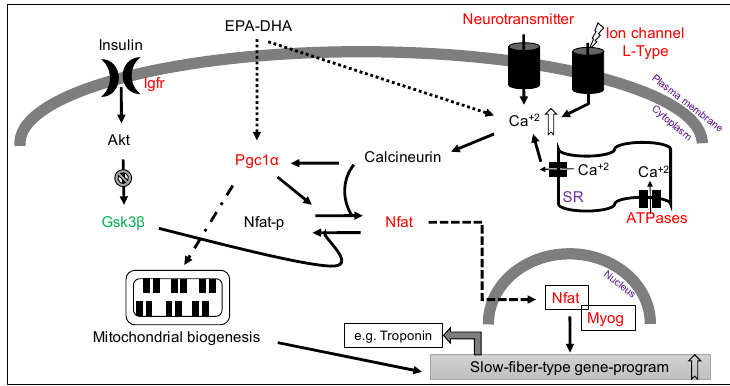
Figure 4. Schematic representation of the role of ED—enriched HFD on the gSkM transcriptome and modulation of ageing and/or obesity-induced sarcopenia in C57Bl/6J mice. Briefly, ED enriched HFD downregulates glucose synthase kinase 3 beta ( Gsk3 β ) that phosphorylates nuclear factor of activated T cells ( Nfatc4 ) and excludes it from entering into the nucleus. It also increases cytosolic calcium concentrations that in turn regulate calcineurin that then dephosphorylates Nfat allowing its localization in the nucleus. Upon localization, Nfat forms complex with myogenin ( Myog ) to turn on slow-fiber-type specific gene-program for e.g., Troponin C1. Pgc1 α , a known master regulator of mitochondrial biogenesis was also seen upregulated by ED enriched HFD that could act upon multiple targets, one of which regulating dephosphorylation of Nfatc4 isoforms and its further nuclear localization.